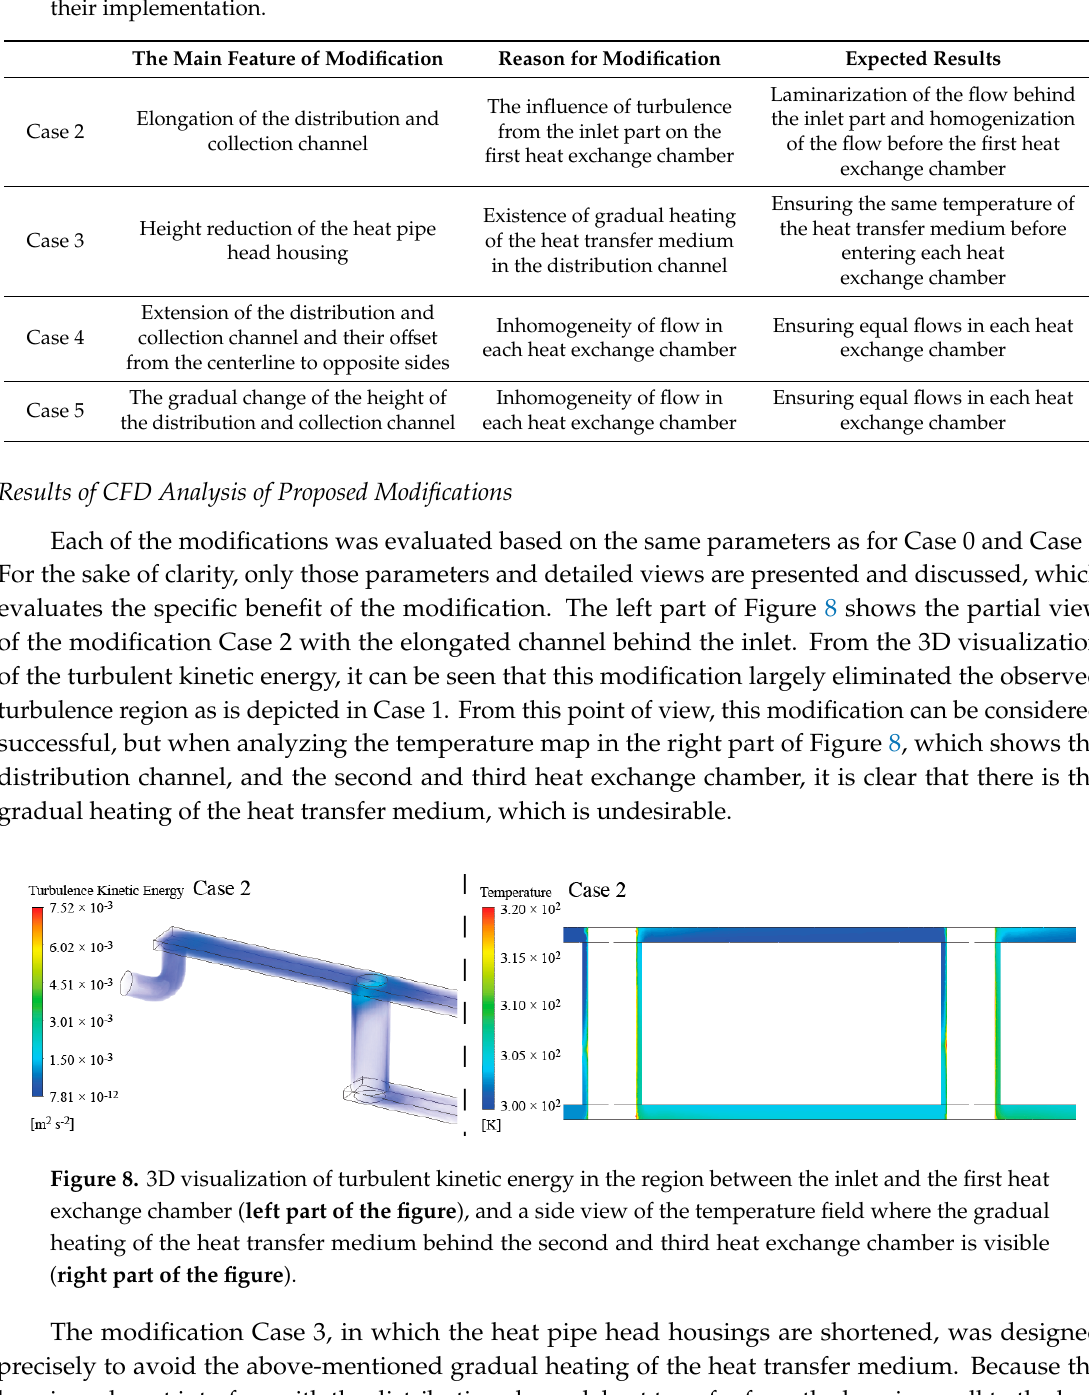
Table 1. The summary of the main feature of each modification and the expected results of their implementation.